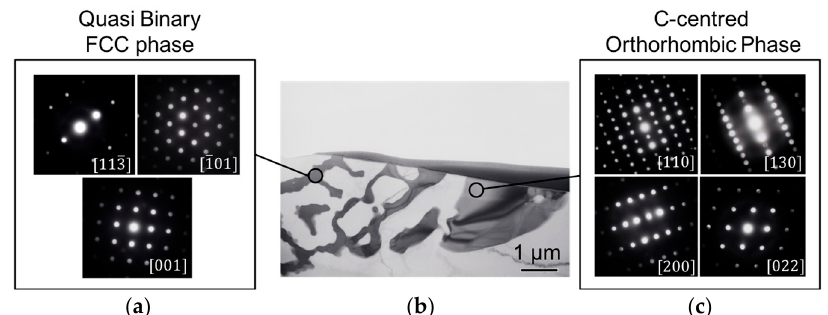
Figure 5. TEM observation of Mg-4Nd-5Zn in Selected Area Electron Diffraction ( a ) and ( c ) of two distinct intermetallic phases; ( b ) bright field